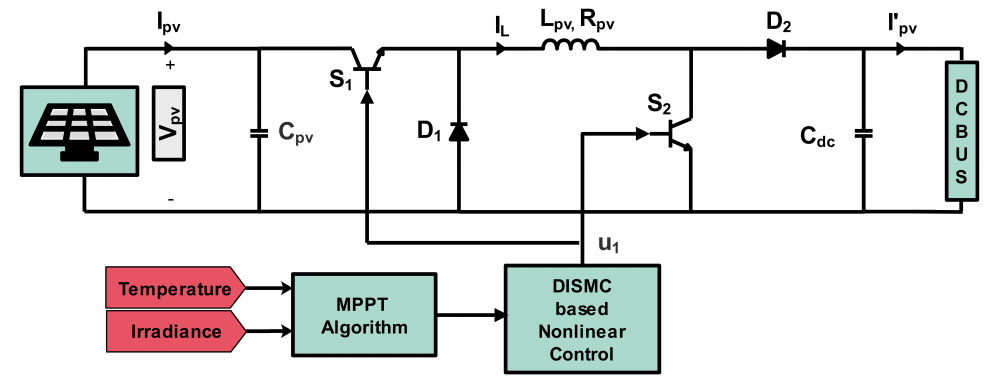
Figure 2. Component-wise breakdown of a PV-based generation